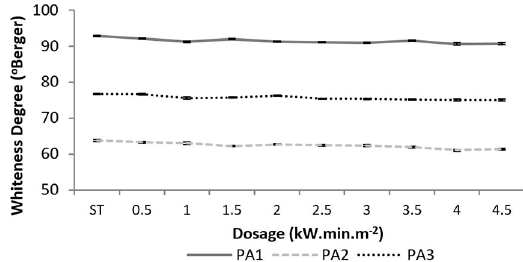
Figure 6. Whiteness Degree of the polyamide fabrics treated with different dosages.